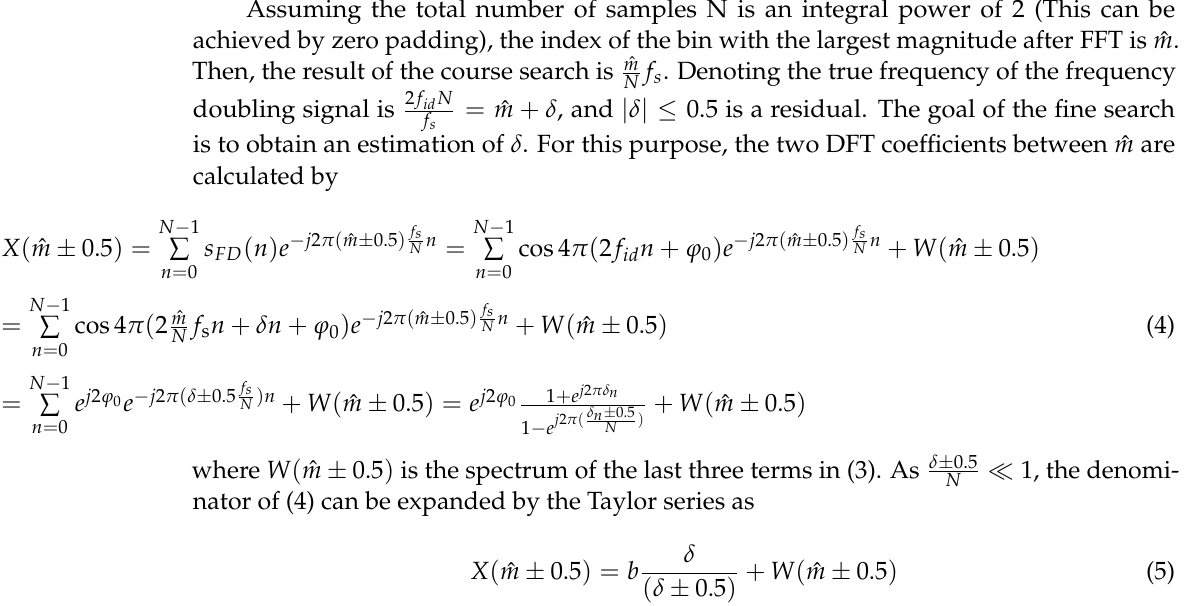
Figure 3. Flow chart of center frequency estimation.